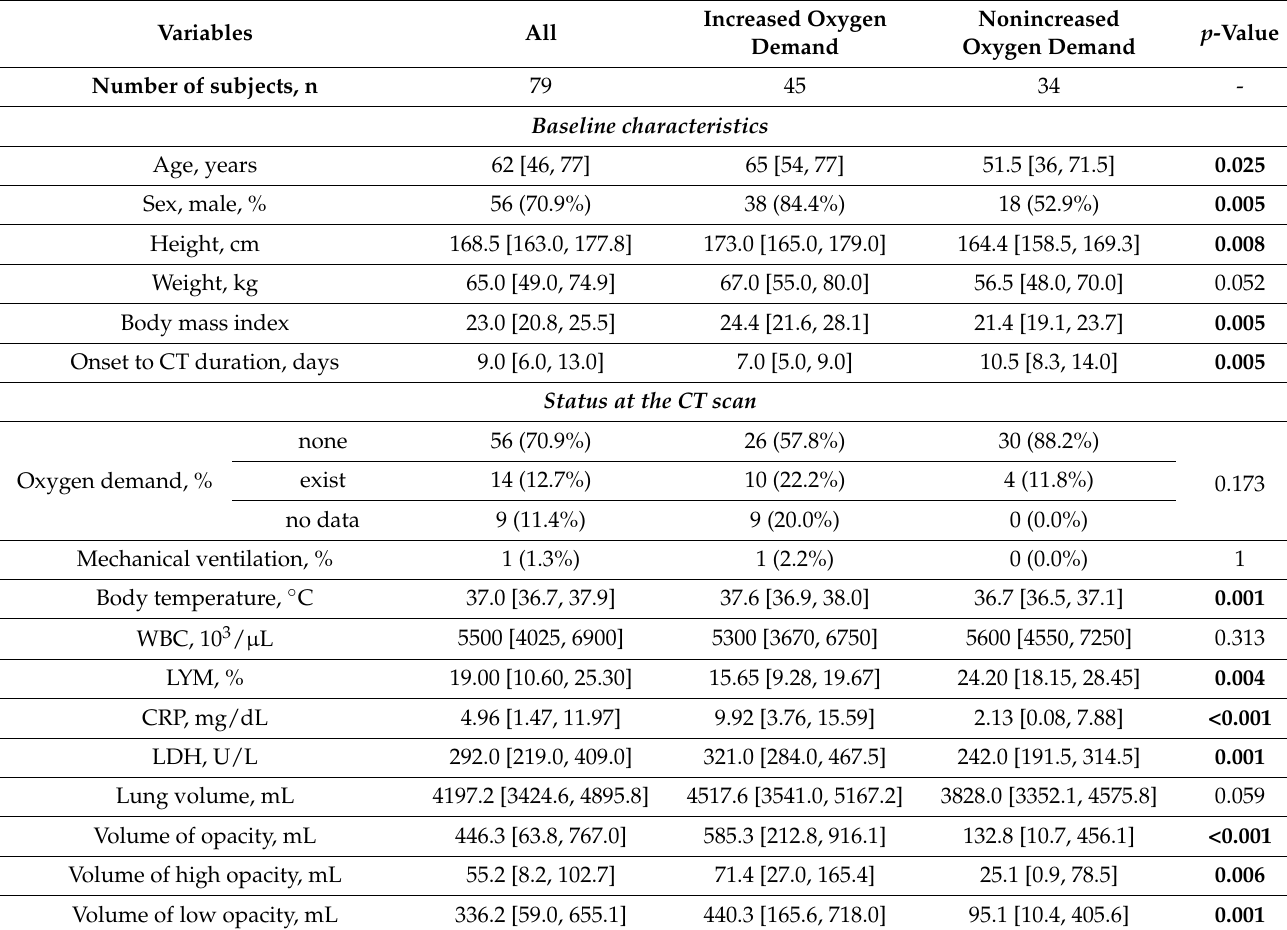
Table 1. Demographic and clinical characteristics of the study